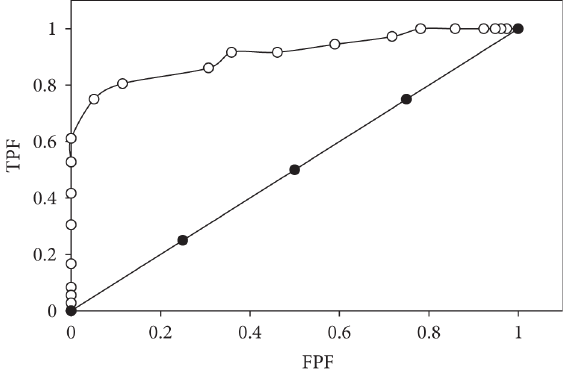
F 7: Receiver operating characteristic curve (ROC) for (4). Training set is represented by white points and random classi�er by black points. TPF (true positive fraction)= sensitivity and FPF (false positive fraction) = 1-speci�city, for different thresholds of class function (between 1.0 and − +1.0